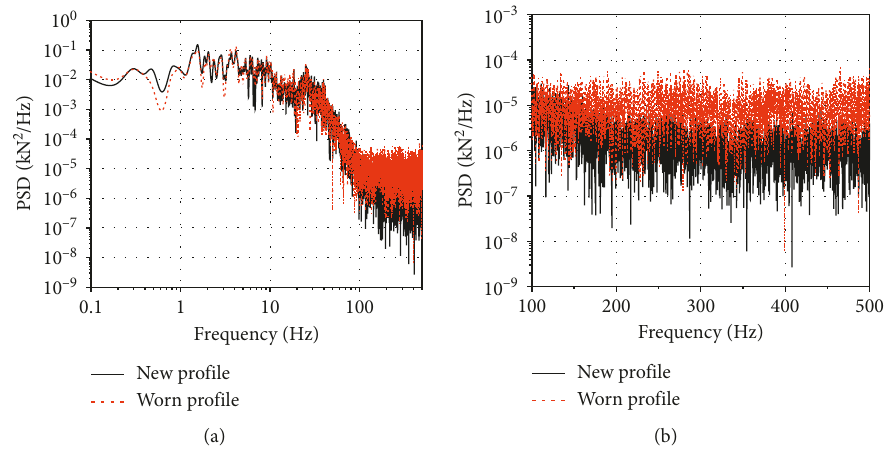
Figure 19: Power spectral density of lateral wheel-rail force: (a) overall; (b) enlarged diagram of 100 ∼ 500Hz.